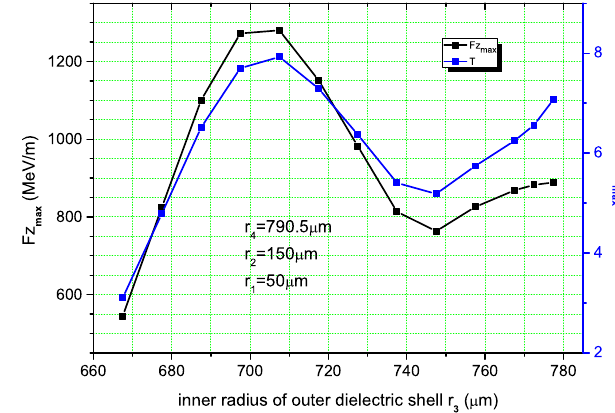
I.FIG. 9. (Color) The value of the composite longitudinal electric FIG. 11. (Color) The value of the composite longitudinal elec- field at the first axial maximum and corresponding transformer tric field at the first axial maximum and corresponding trans- ratio versus the external radius of the inner dielectric shell. The former ratio versus the inner radius of the outer dielectric shell. ¼ 777 : 5 (cid:1) m and r ¼ radii of the outer dielectric shell are r The radii of the inner dielectric shell are 50 and 150 (cid:1) m . The 3 4 790 : 5 (cid:1) m . The rest of the parameters are the same as in Table external radius of the outer dielectric shell is 790 (cid:1) m . The other parameters are the same as those in Table